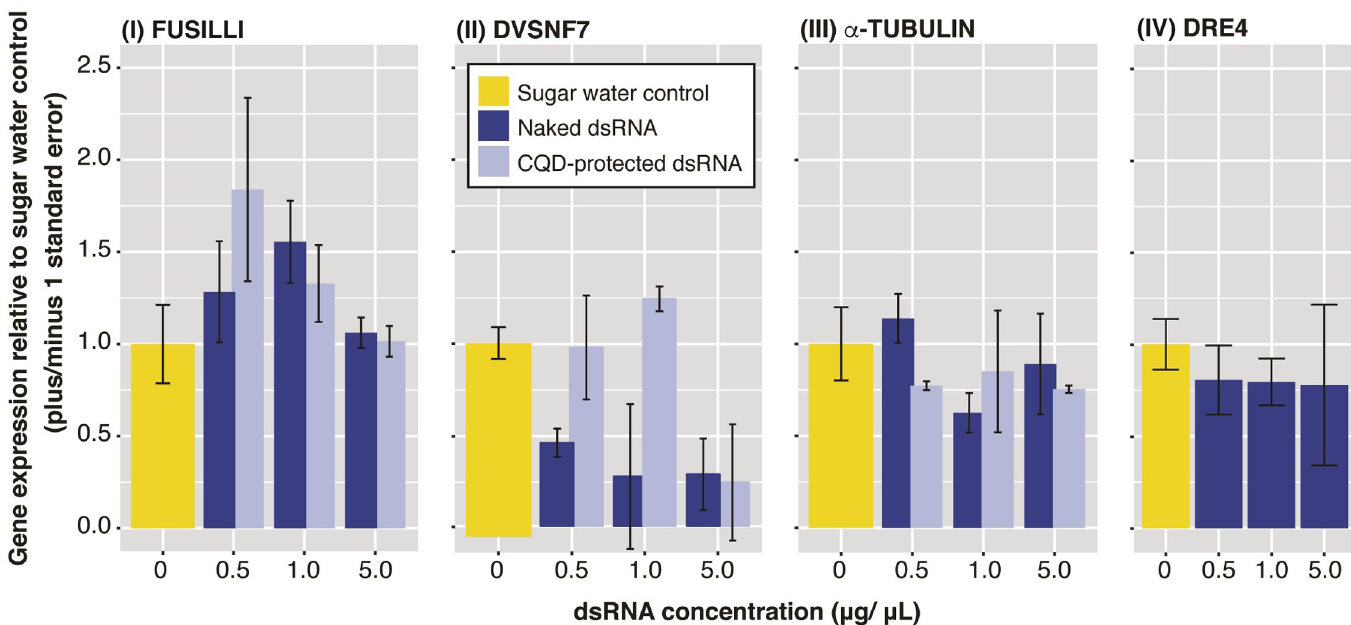
Fig 7. Relative gene expression for P . dominula wasps fed four dsRNAs gene targets of different concentrations with and without CQD protection. Each bar corresponds to the pooled mean ± SE for three wasps, compared to three wasps in a control treatment that were fed only sugar water (with no dsRNA).